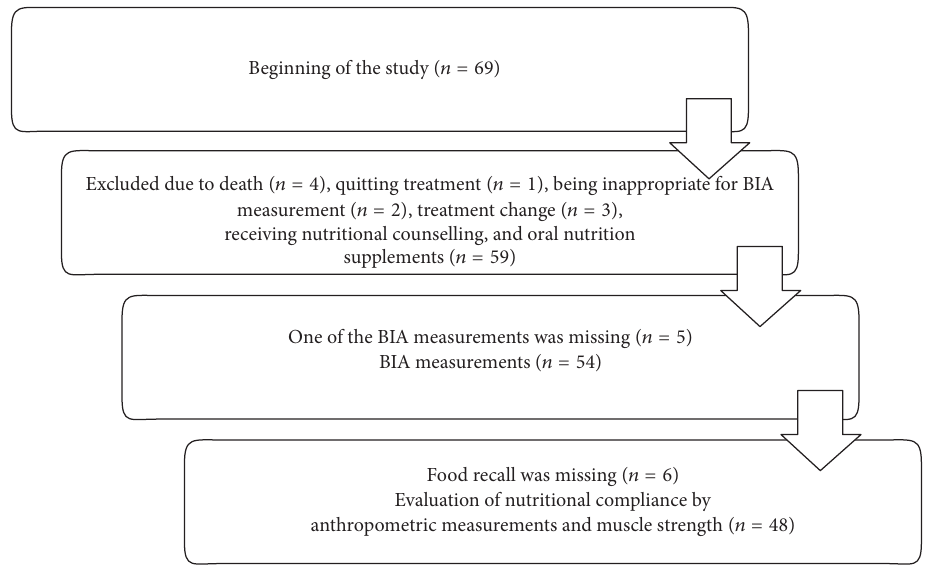
Figure 1: Flowchart of the